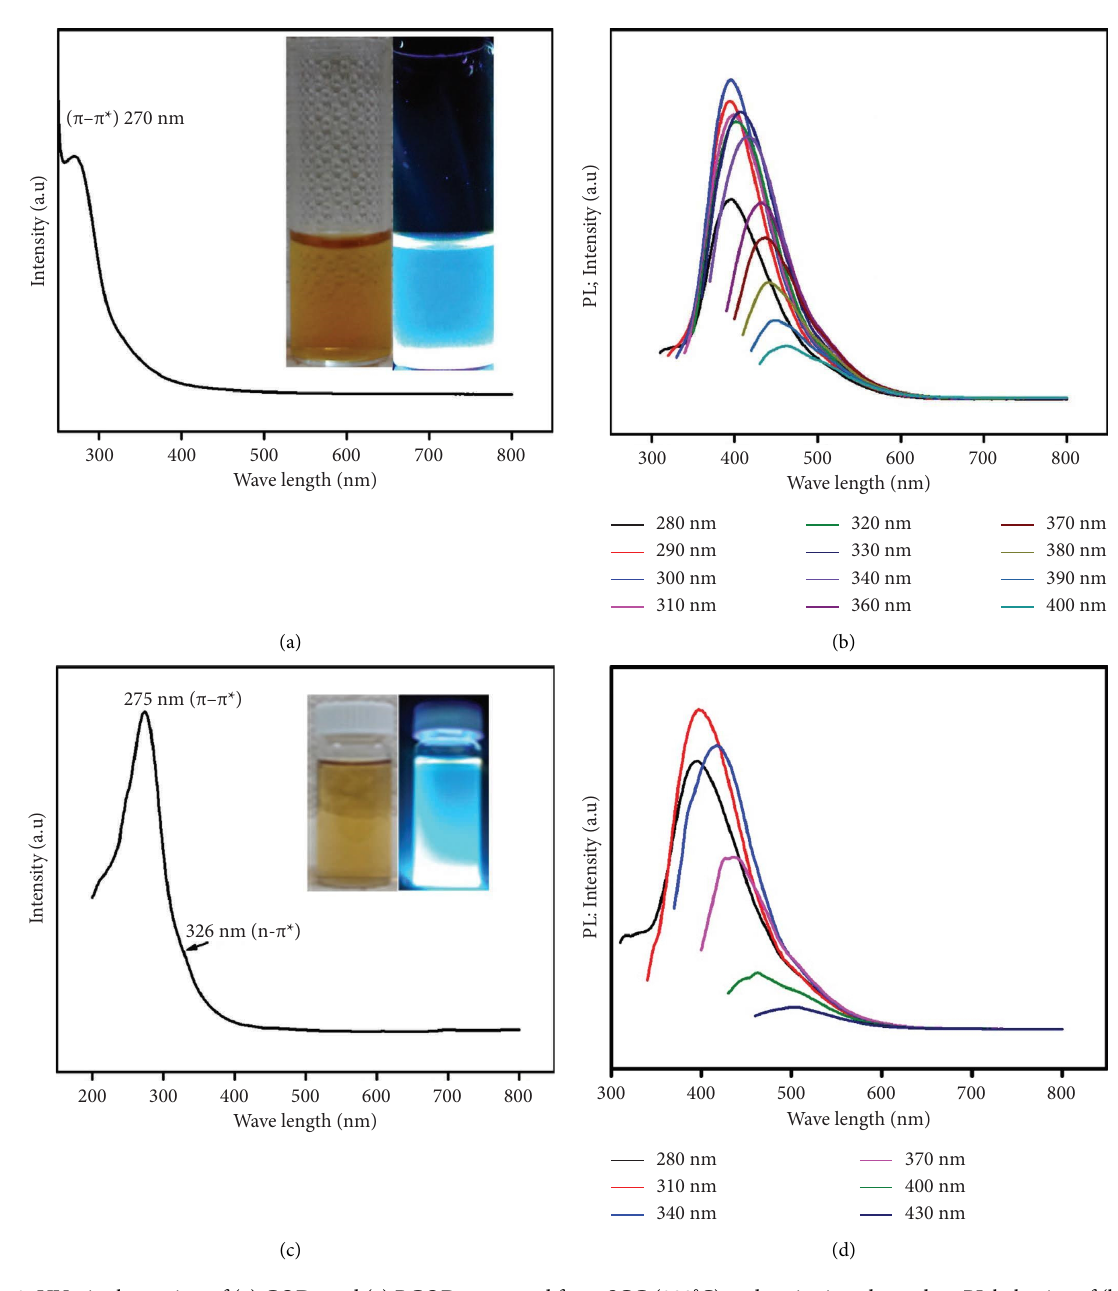
Figure 3: UV-vis absorption of (a) GQDs and (c) BGQDs prepared from SCG (200 ° C) and excitation-dependent PL behavior of (b) GQDs from 280 to 400nm and (d) BGQDs from 280 to 430nm. Inset photographs of GQDs solution in (a) and BGQDs solution in (c) were taken under visible and 365nm UV light,